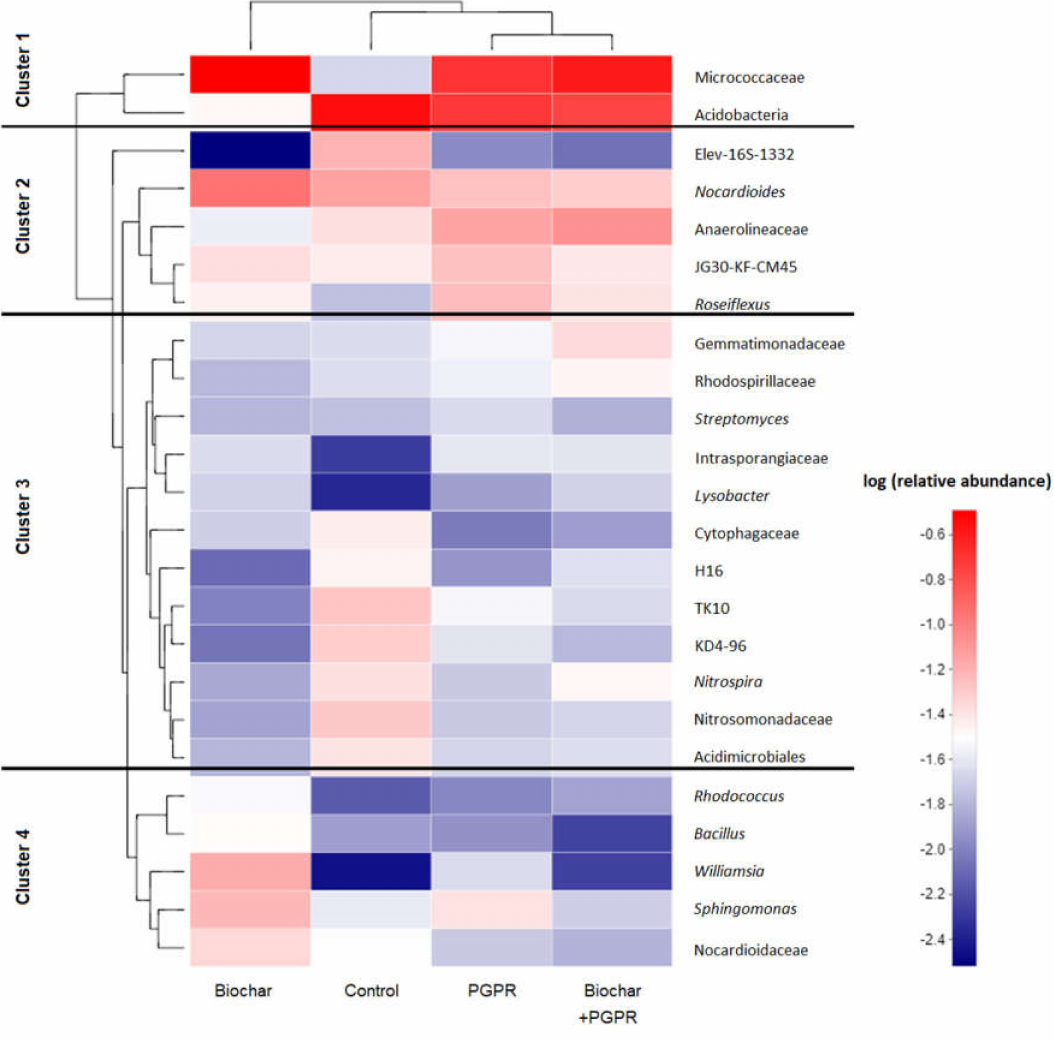
Figure 2. Relative abundances and community compositions of dominant bacterial genera in soils for each treatment. Their phylogenetic relationships are shown on the left tree. The top tree shows the cluster relationship among